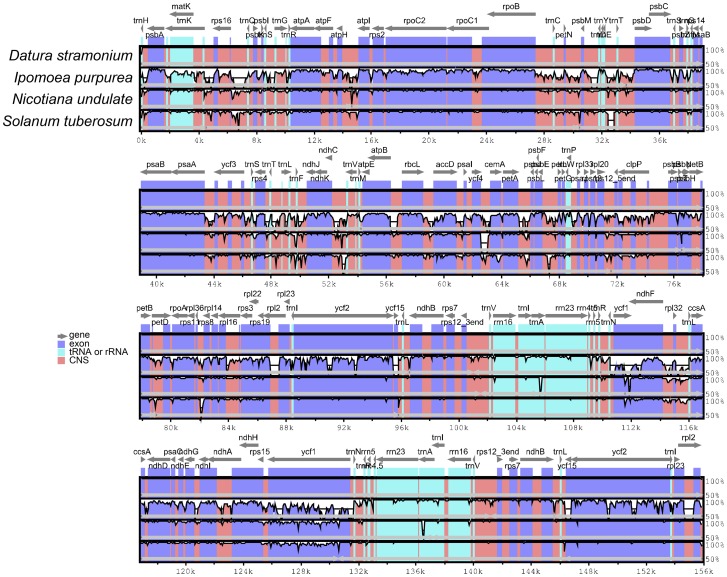
Comparison of four chloroplast genomes using mVISTA program.Grey arrows and thick black lines above the alignment indicate genes with their orientation and the position of the IRs, respectively. A cut-off of 70% identity was used for the plots, and the Y-scale represents the percent identity between 50–100%. Genome regions are color-coded as protein-coding (exon), rRNA, tRNA and conserved noncoding sequences (CNS).